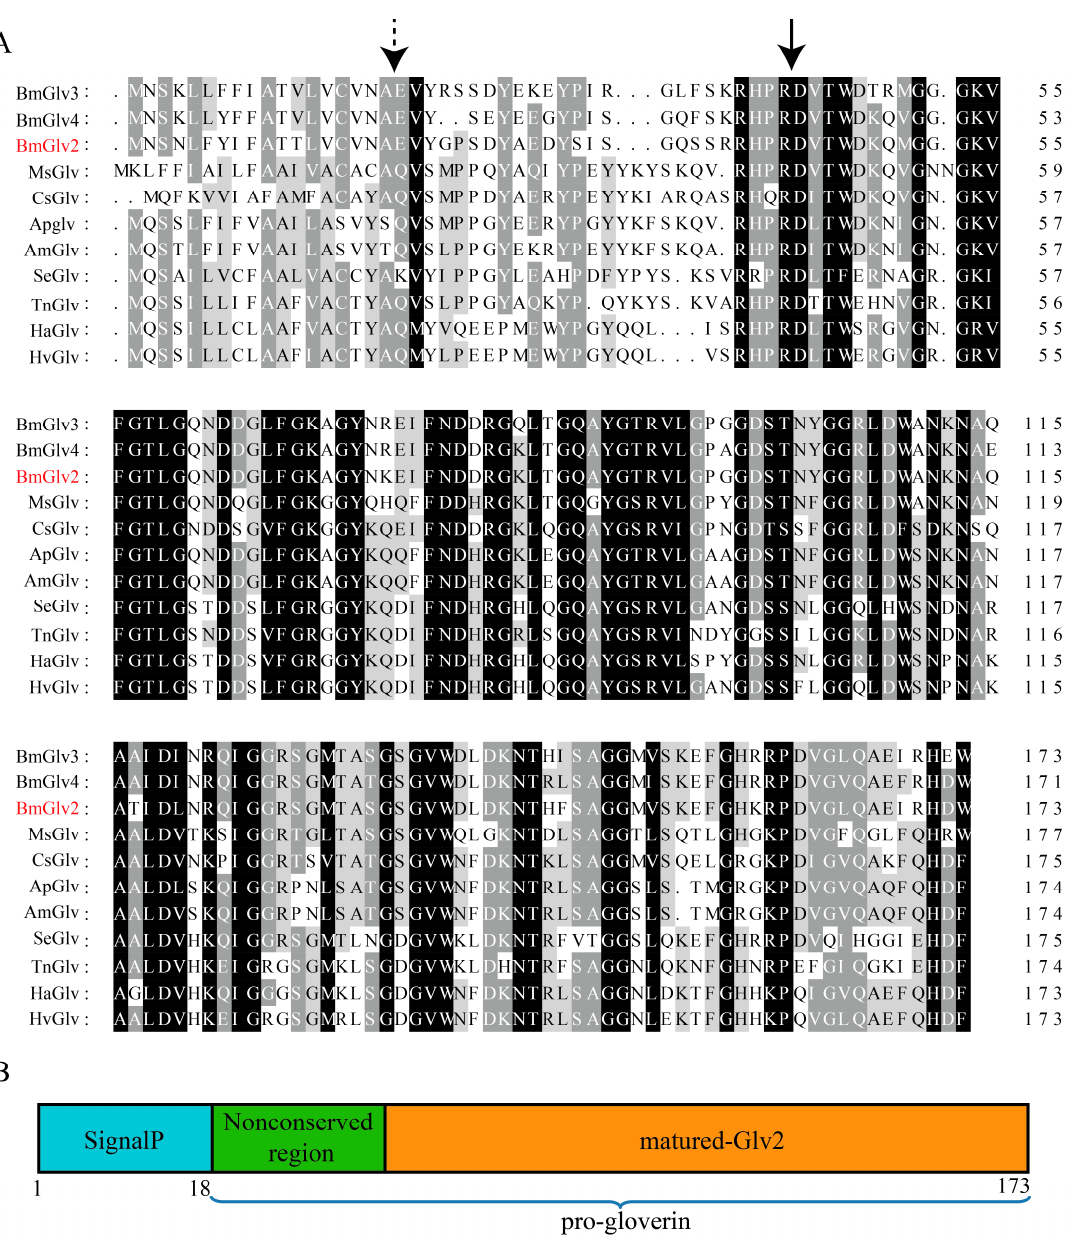
Figure 1. Sequence analysis of Glv in Lepidoptera. ( A ) Multiple sequence alignments of Bombyx mori BmGlv3 (NP_001093312.1), BmGlv4 (NP_001037684.1), BmGlv2 (NP_001037683.1), MsGlv from Manduca sexta (CAL25129.1); CsGlv from Chilo suppressalis (AHC94952.1); ApGlv from Antheraea pernyi (ACB45565.1); AmGlv from Antheraea mylitta (ABG72699.1); SeGlv from Spodoptera exigua (AKJ54490.1); TnGlv from Trichoplusia ni (AAG44367.1); HaGlv from Helicoverpa armigera (ALT16898.1); HvGlv from Heliothis virescens (ACR78446.1). The signal peptide cleavage side was marked with dotted arrow; and the mature Glv active site was marked with the solid arrow. Alignments were performed with Clustalx. Conserved, highly conserved and identical amino acid residues are highlighted in light gray, gray and black, respectively. ( B ) A diagram to show the organization of BmGlv2 Signalp, signal peptide.